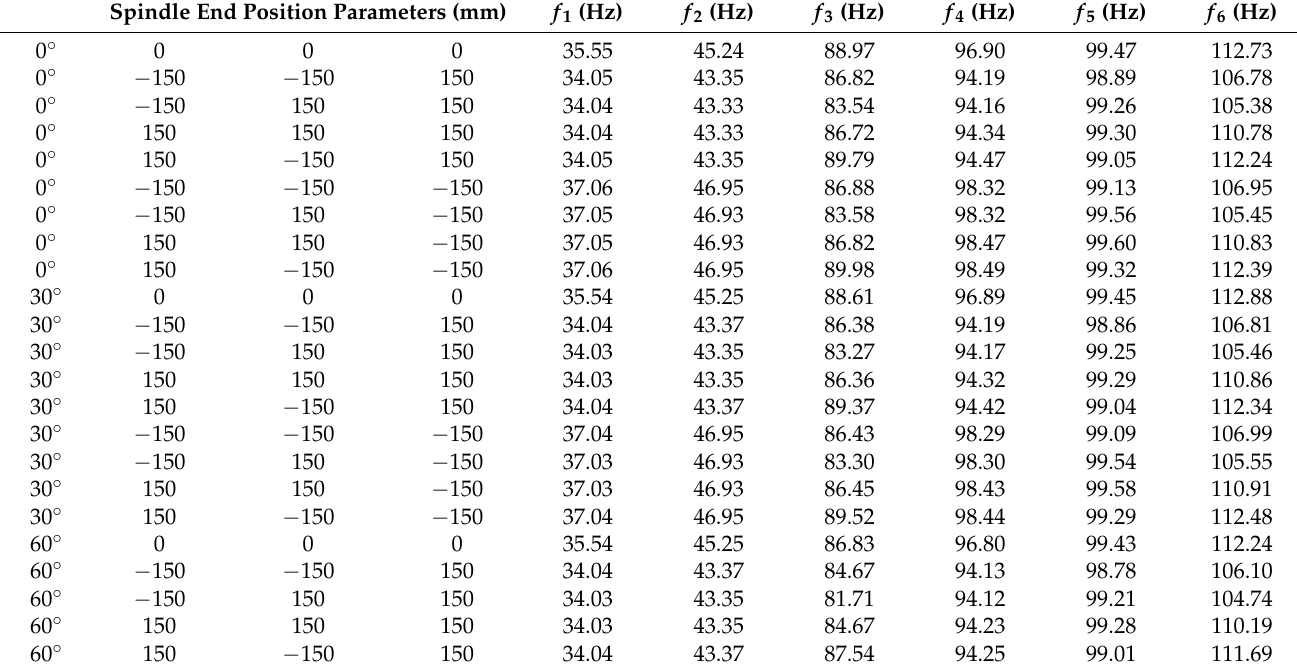
Table 7. Machine tool modal parameters at different positions of the spindle end. Spindle End Position Parameters